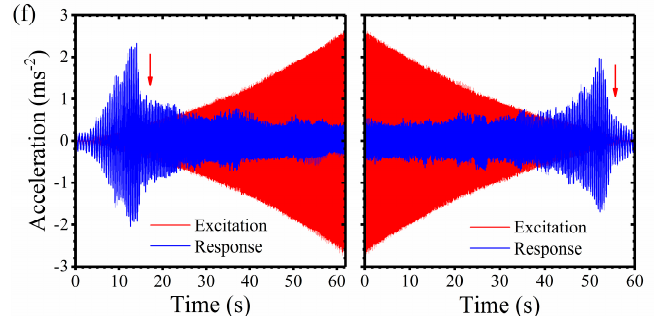
Figure 10. Time history signals of acceleration under linear sinusoidal sweep excitation. ( a ) Excitation displacement amplitude: B = 0.5 mm. ( b ) B = 1.0 mm. ( c ) B = 1.5 mm. ( d ) B = 1.5 mm. ( e ) B = 2.5 mm. ( f ) B = 3.0 mm.